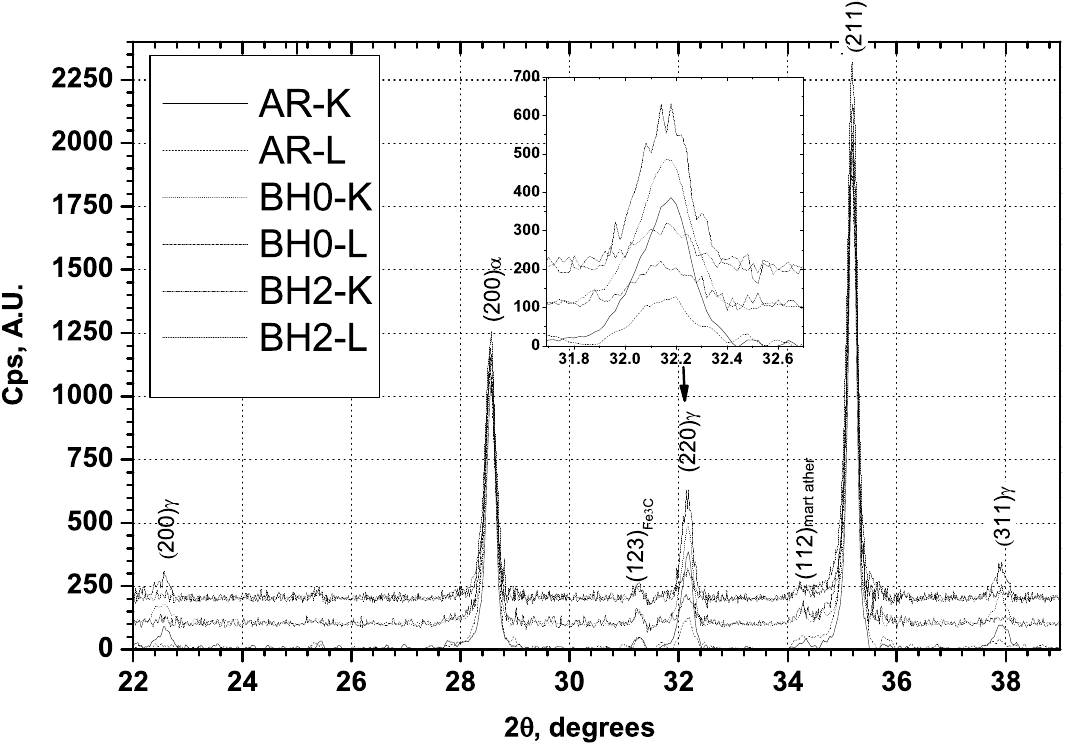
Figure 11. X-ray diffraction diffractogram for the TRIP5 steel for the non-strained (K) and strained (L) samples without and with paint-baking at 170 ◦ C for 20